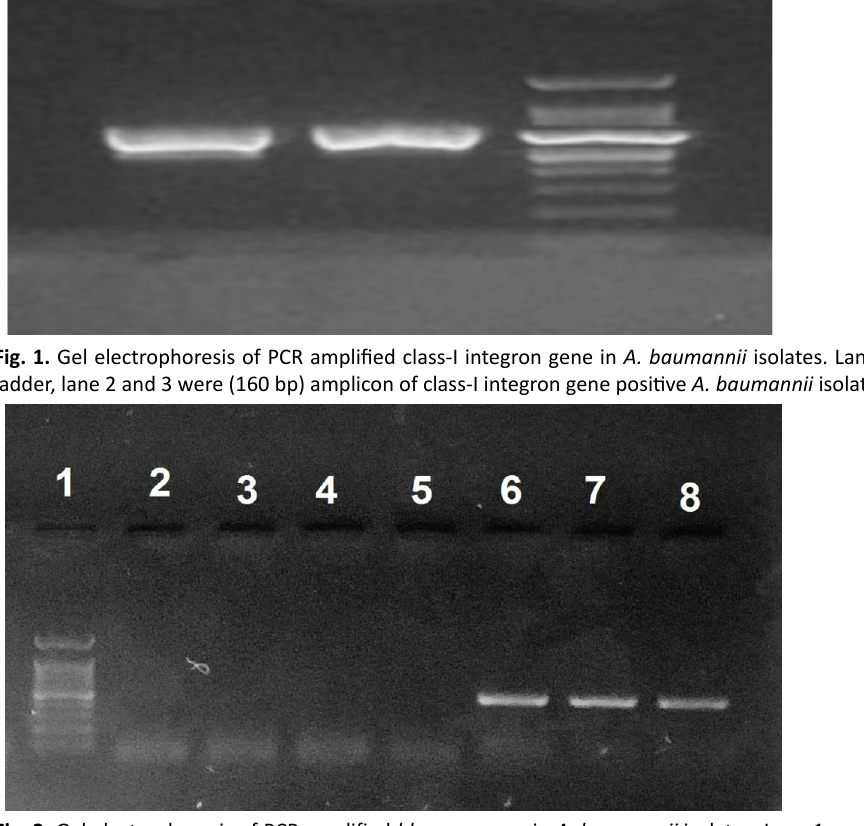
Fig. 2. Gel electrophoresis of PCR amplified bla lane 6, 7 and 8 were (501 bp) amplicons of bla were bla amplicon gene negative A. baumannii oxa-23like